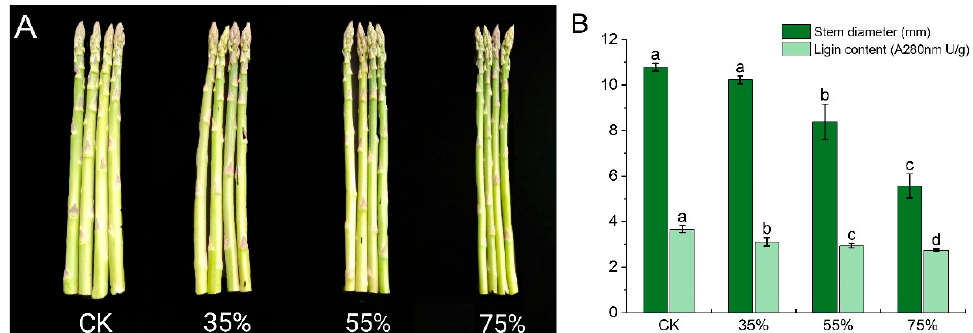
Figure 1. ( A ) Effect of shading on asparagus tender stem. ( B ) Phenotypic characteristics of asparagus tender stem under different shading treatments. ( C ) Changes of lignin content in asparagus tender stem under different shading treatments. Each bar represents the mean ± SD. T test at a significance level of 0.05 ( p <0.05). Different letters (a, b, c) indicate significant differences, and the same letter indicates no significant differences.